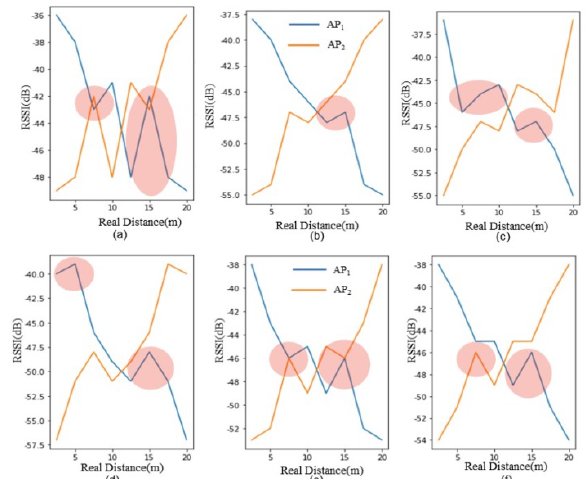
Figure 14(a)~(f). Six sets of RSSI data and correspond- ing confusion regions